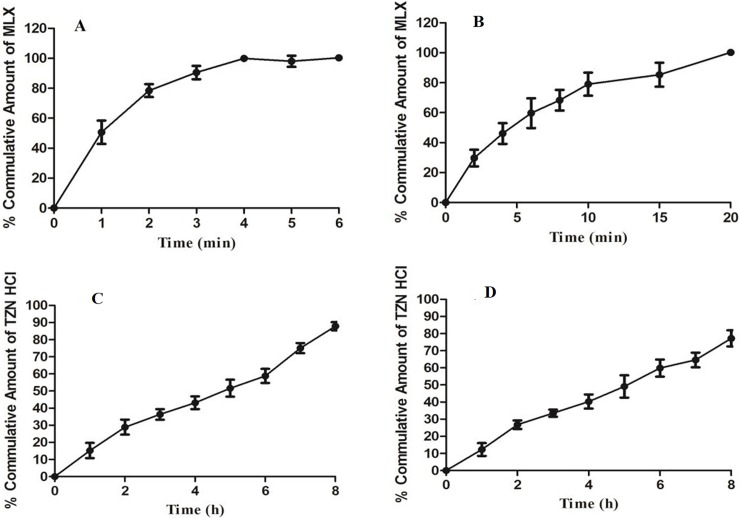
Graphical illustration of in-vitro dissolution and ex-vivo permeation of MLX and TZN.A and B are showing drug release and permeation of MLX while C and D are describing release and permeation of TZN from bilayer mucoadhesive buccal film.